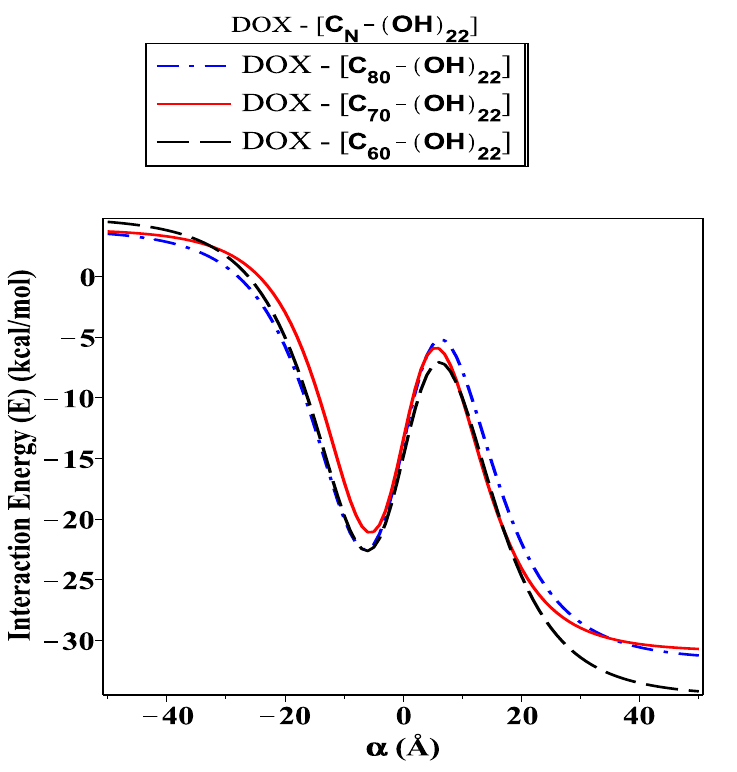
Figure 7. Interaction energy ( E ) arising from DOX molecule as tow-connected spheres, each as an arbitrary point interacting with fullerene derivatives (C N -[OH] 22 ).